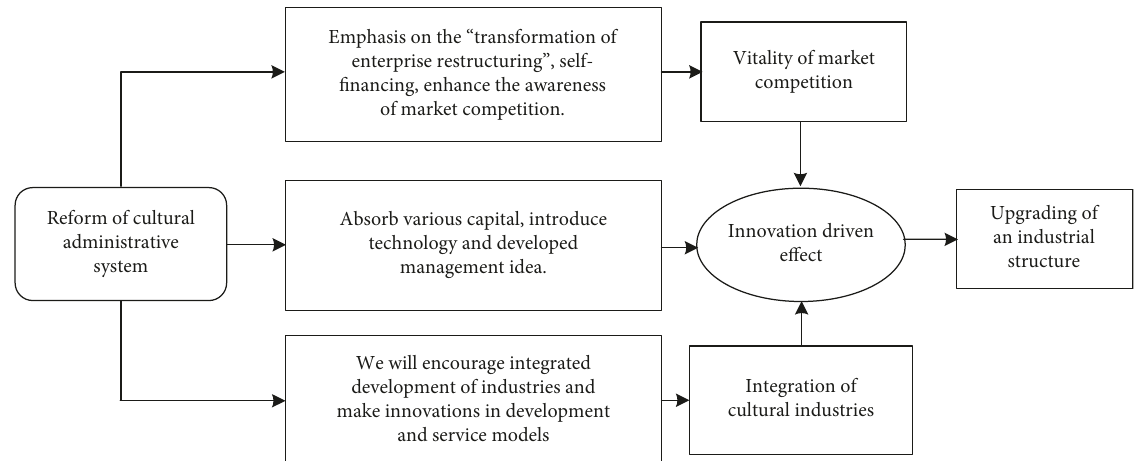
Figure 1: The influence mechanism of reform of cultural administrative system on industrial structure